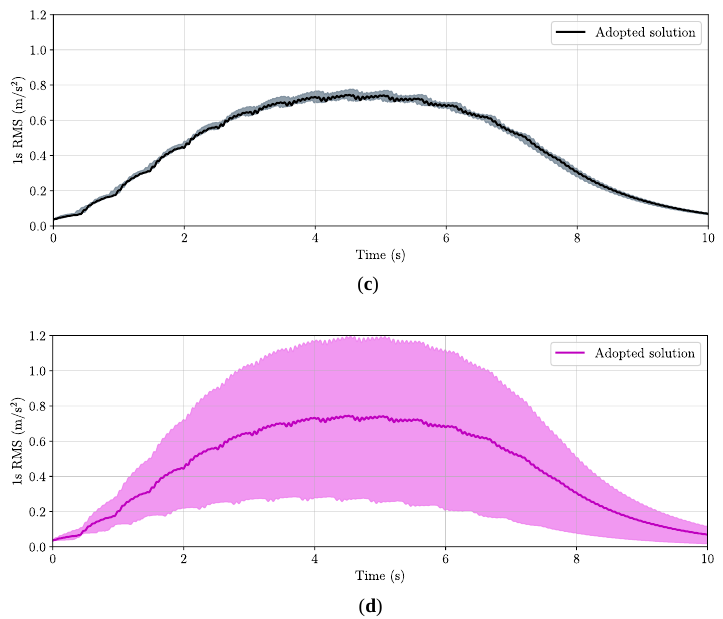
Figure 16. Parametric analysis varying the GLFs: ( a ) First harmonic, ( b ) Second harmonic. ( c ) Third harmonic. ( d ) Fourth